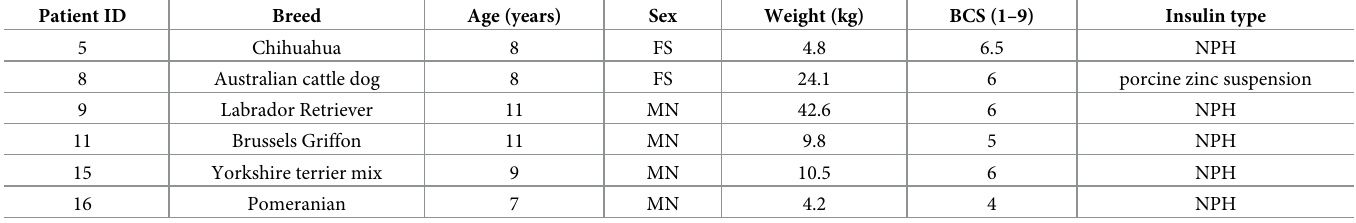
Table 1. Patient characteristics at